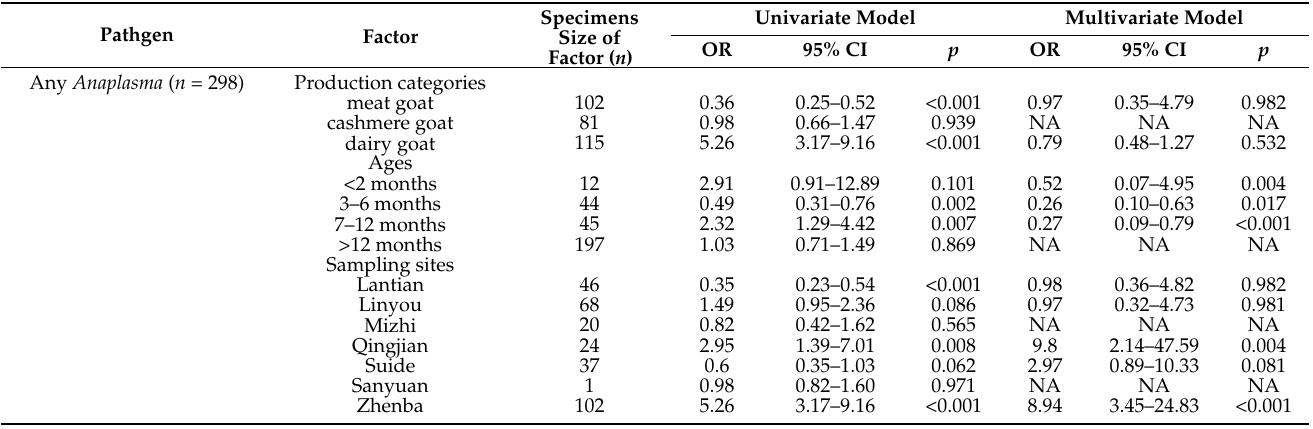
Table 6. Association between production categories and the occurrence of Anaplasma in four age groups from seven sampling sites, as indicated by univariate and multivariate